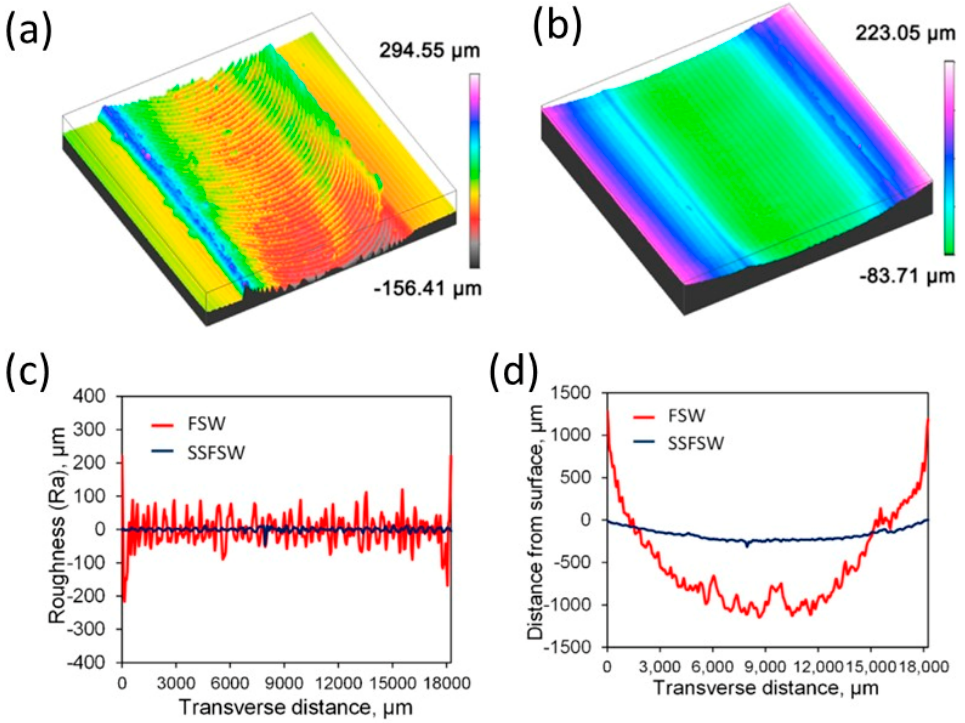
Figure 14. The surface quality characteristics and the surface roughness, respectively, obtained us- ( a , c ) conventional FSW tool and ( b , d ) SSFSW tool [118] (has permission from